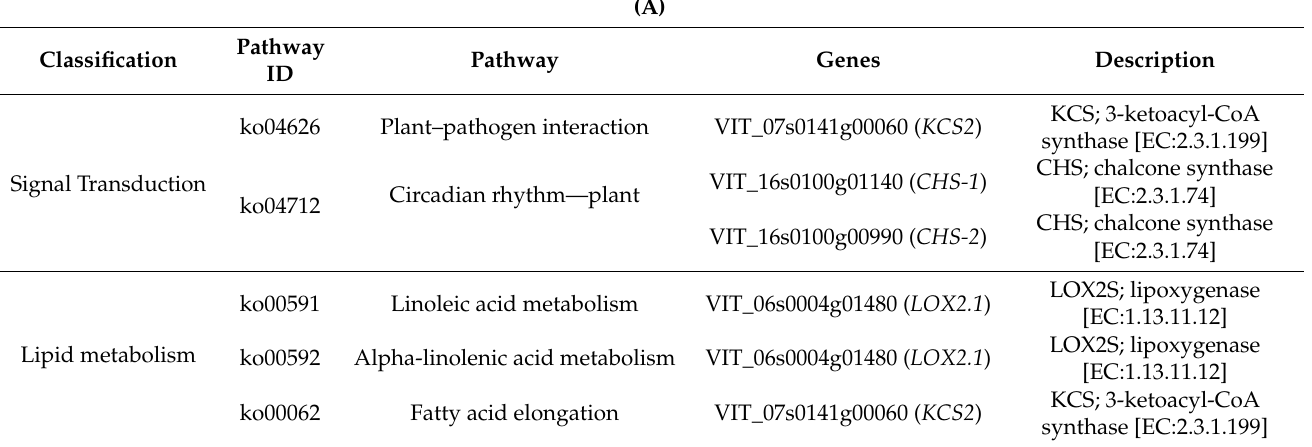
Figure 4. Expression of common differential genes (DEGs) in groups under different freezing treatments. ( A ): Venn diagrams of the changes in DEGs between the two temperatures at the same time; ( B ): Venn diagrams of the changes in the DEGs of Profile 3 under the two temperatures; ( C ): Venn diagrams of the changes in DEGs between different times at − 10 ◦ C; ( D ): Venn diagrams of the changes in DEGs between different times at − 16 ◦ C. Table 1. ( A ) Kyoto Encyclopedia of Genes and Genomes (KEGG) enrichment analysis of common DEGs under different temperatures. ( B ) KEGG enrichment analysis of common DEGs at different times.